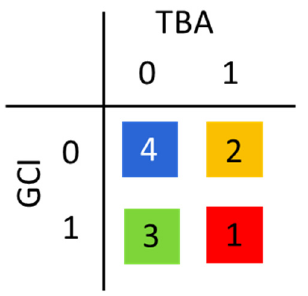
Figure 2. Conceptual fire regime classification framework (see Section 2.3 for a description; TBA— Total Burned Area; GCI—Gini concentration index).